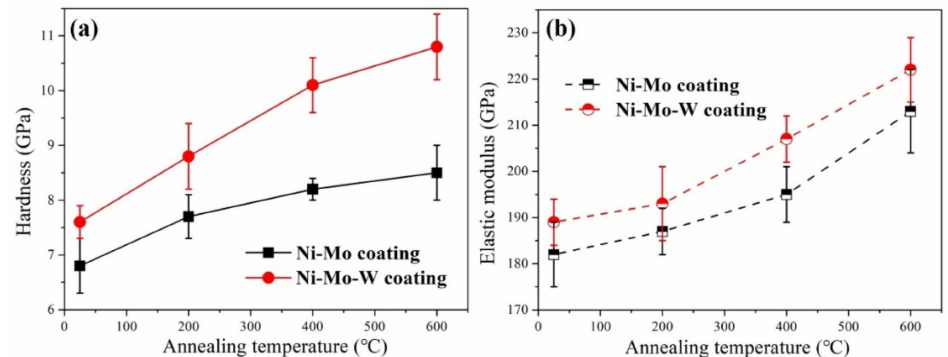
Figure 7. The nano-indentation measured mechanical properties of as-deposited and 200 to 600 ◦ C annealed Ni-Mo and Ni-Mo-W coatings: ( a ) Hardness; and ( b ) elastic modulus.